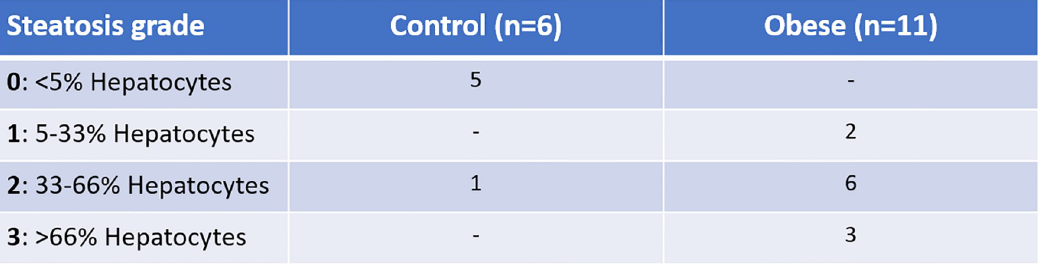
Fig 8. Steatosis grade in the control group and obese